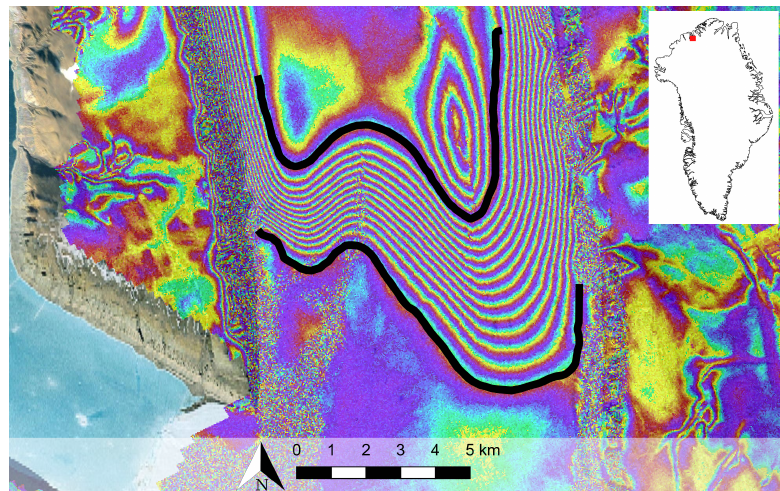
Figure 3. Geocoded double difference interferogram of the grounding zone of Ryder Glacier derived from repeat pass SAR data of Sentinel-1A and 1B acquired at 6, 12 and 18 January 2017 (background: Google Earth). Thick black lines indicate the lower and upper boundary of the tidal flexure zone. Inset shows location of Ryder Glacier in North